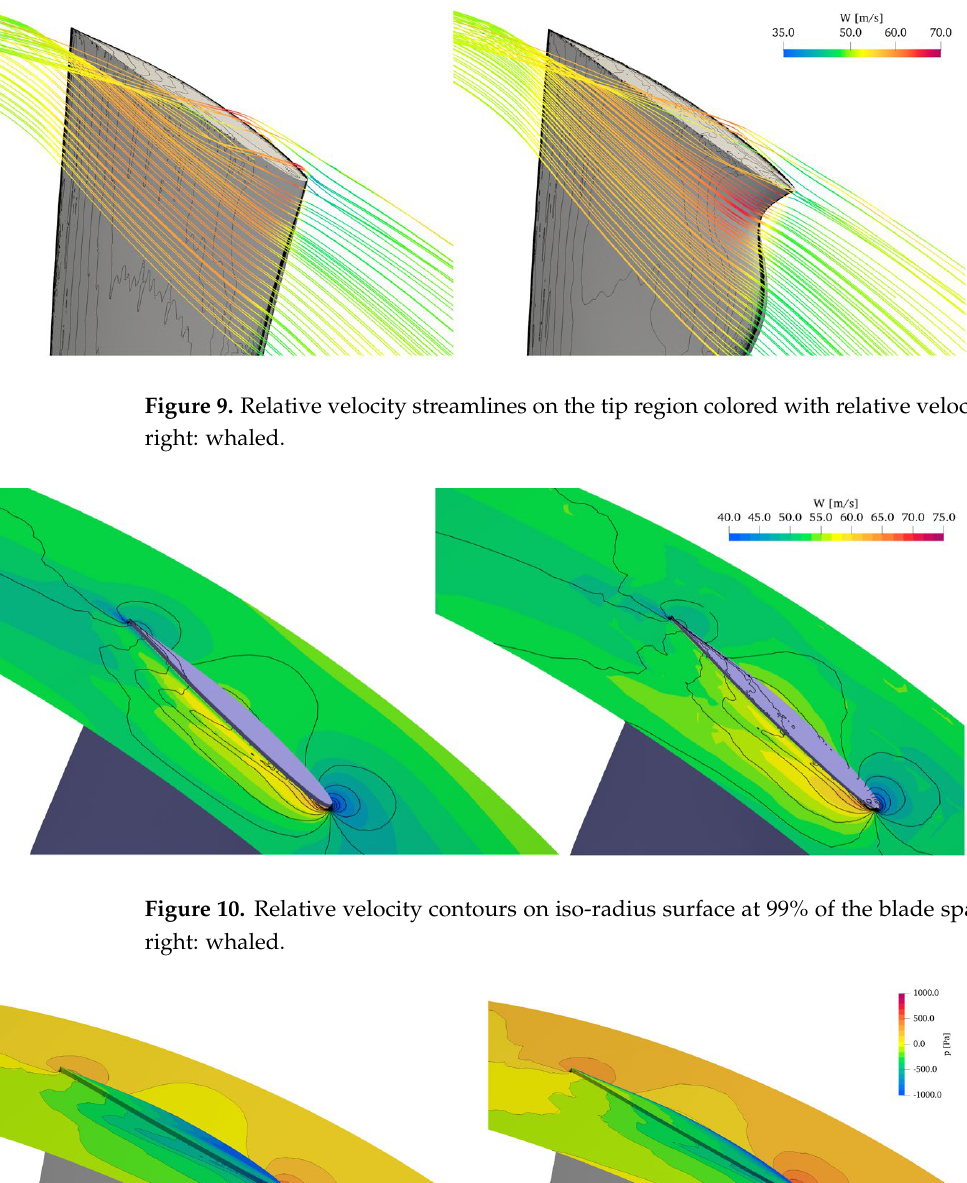
Figure 10. Relative velocity contours on iso-radius surface at 99% of the blade span. Left: datum; right: whaled.